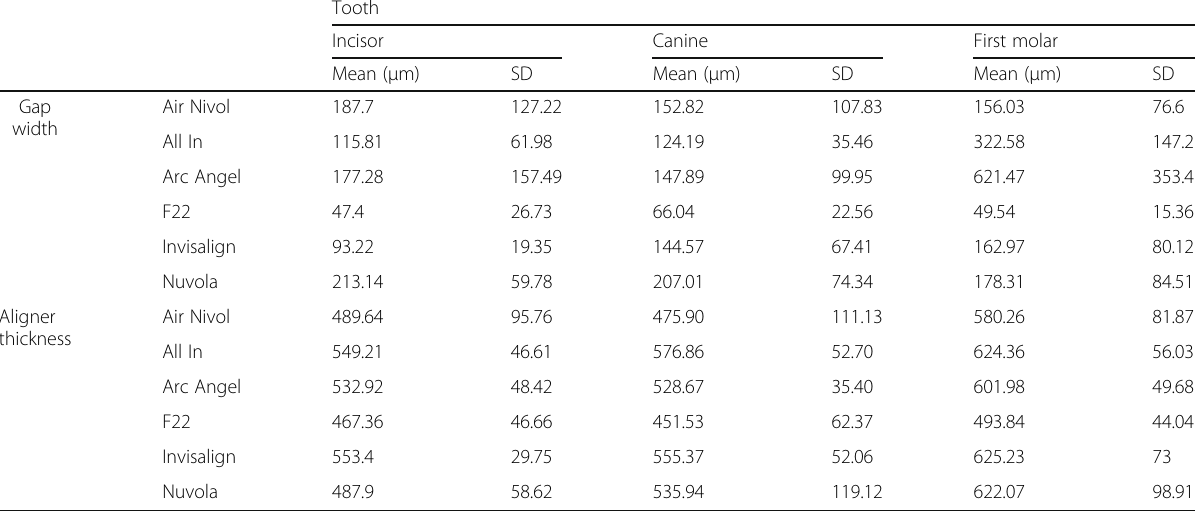
Table 3 Mean gap and aligner thickness values ( μ m) and their respective standard deviations (SD) of the six systems by tooth Tooth